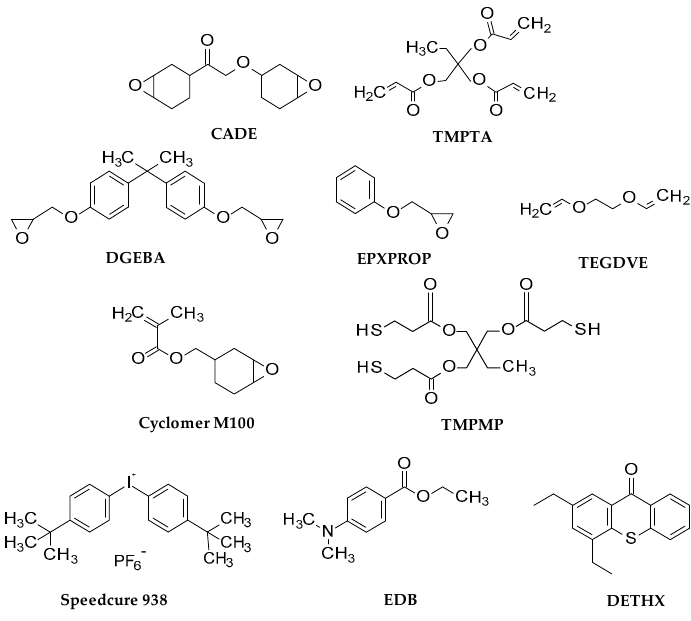
Figure 12. Structures of monomers and other used compounds.